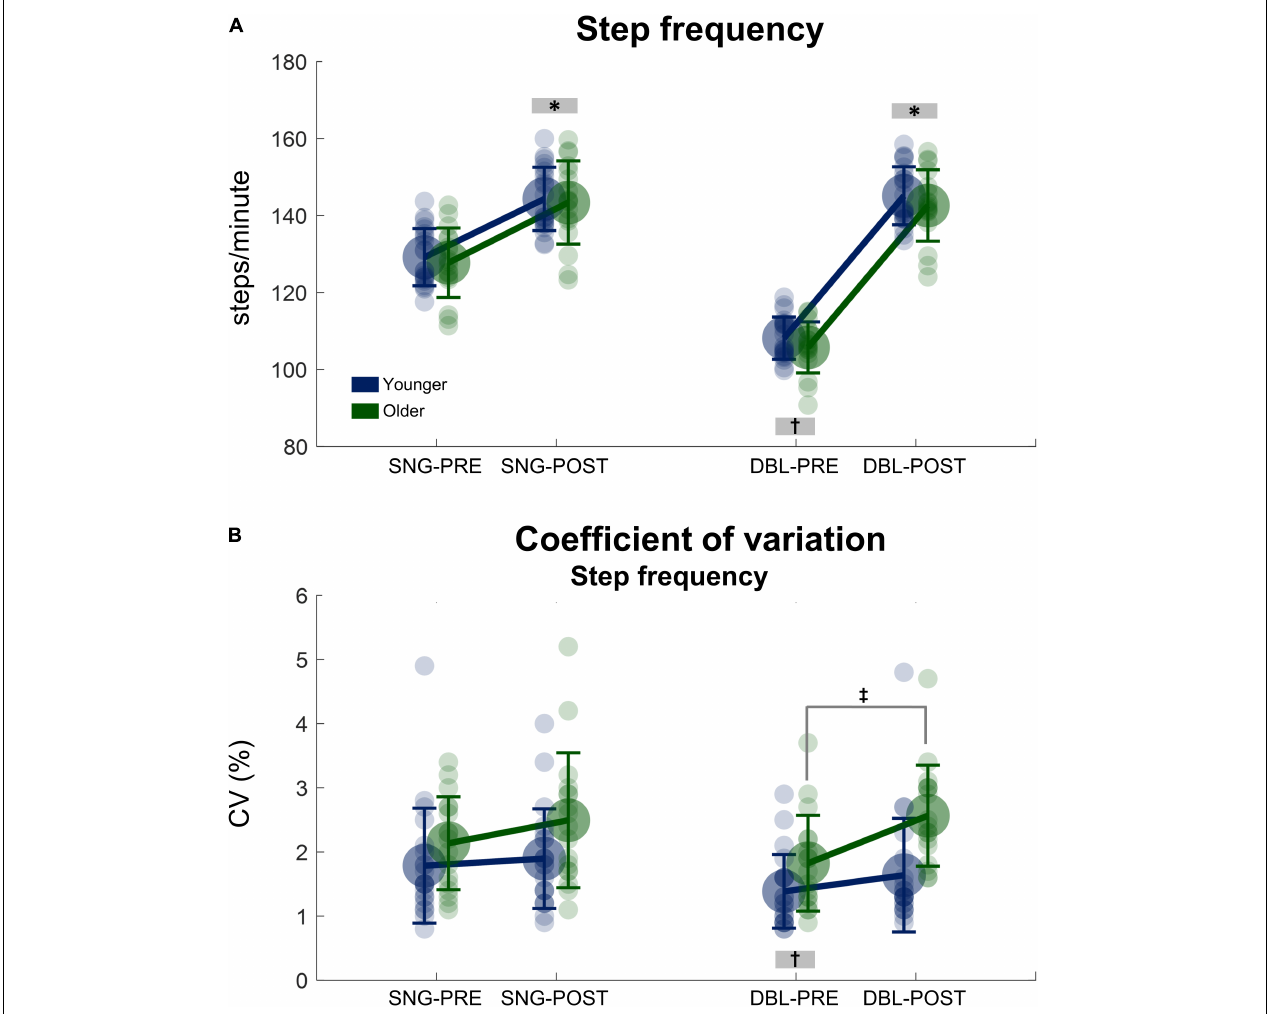
FIGURE 3 | Mean (SD) and individual values of stride frequency (A) and the coefficient of variation of the step frequency (B) before (SNG-PRE) and after single stimuli (SNG-POST), as well as before (DBL-PRE) and after double stimuli (DBL-POST) for younger ( blue ) and older adults ( green ). ∗ Denotes significant difference in relation to PRE ( p < 0.001). † Denotes significant difference in relation to DBL-POST, as well as SNG-PRE and SNG-POST ( p < 0.0001). ‡ Denotes significant difference from PRE to POST for the older adult group ( p =